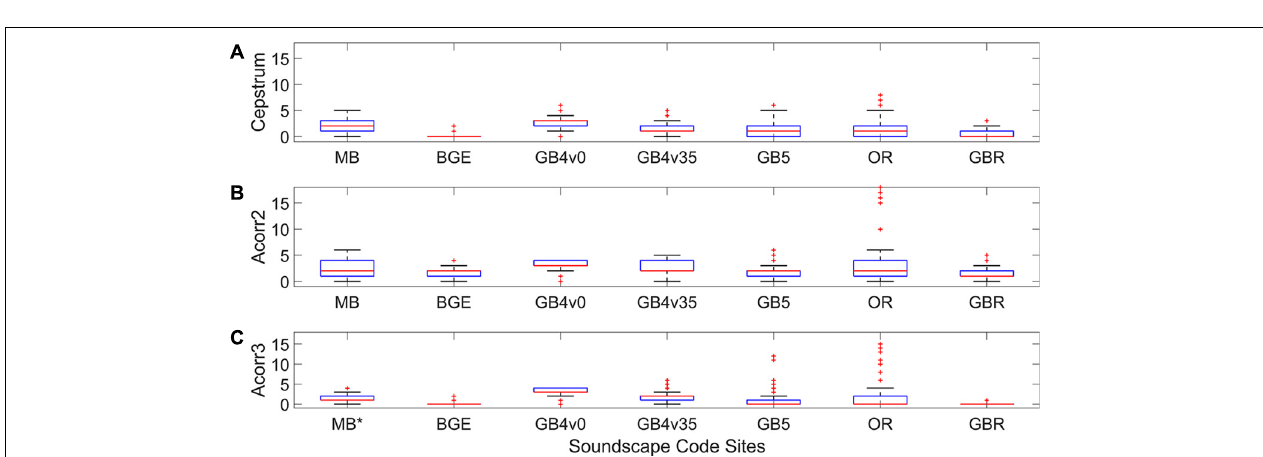
FIGURE 5 | Boxplots of kurtosis values for the Low (A) , Mid (B) , and High (C) bands and crest factor values for the Low (D) , Mid (E) , and High (F) bands at GB4v35. Each box represents the range of metric values in a 10-min time window comprised of metrics calculated over 1-min time windows (each boxplot contains 10 metric values). Circled dots intersecting boxes indicate median values, thick boxes indicate 25 th and 75 th percentile range, narrower lines indicate range of 99% of data, and blue circles indicate outliers.